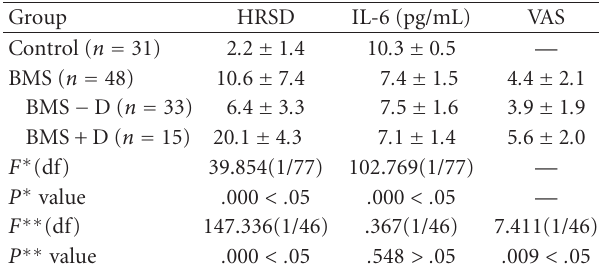
Table 1: Serum IL-6 concentrations and VAS scores in healthy con- trols and BMS patients subdivided into those with (BMS + D) and without (BMS − D) an HRSD score (cid:2)